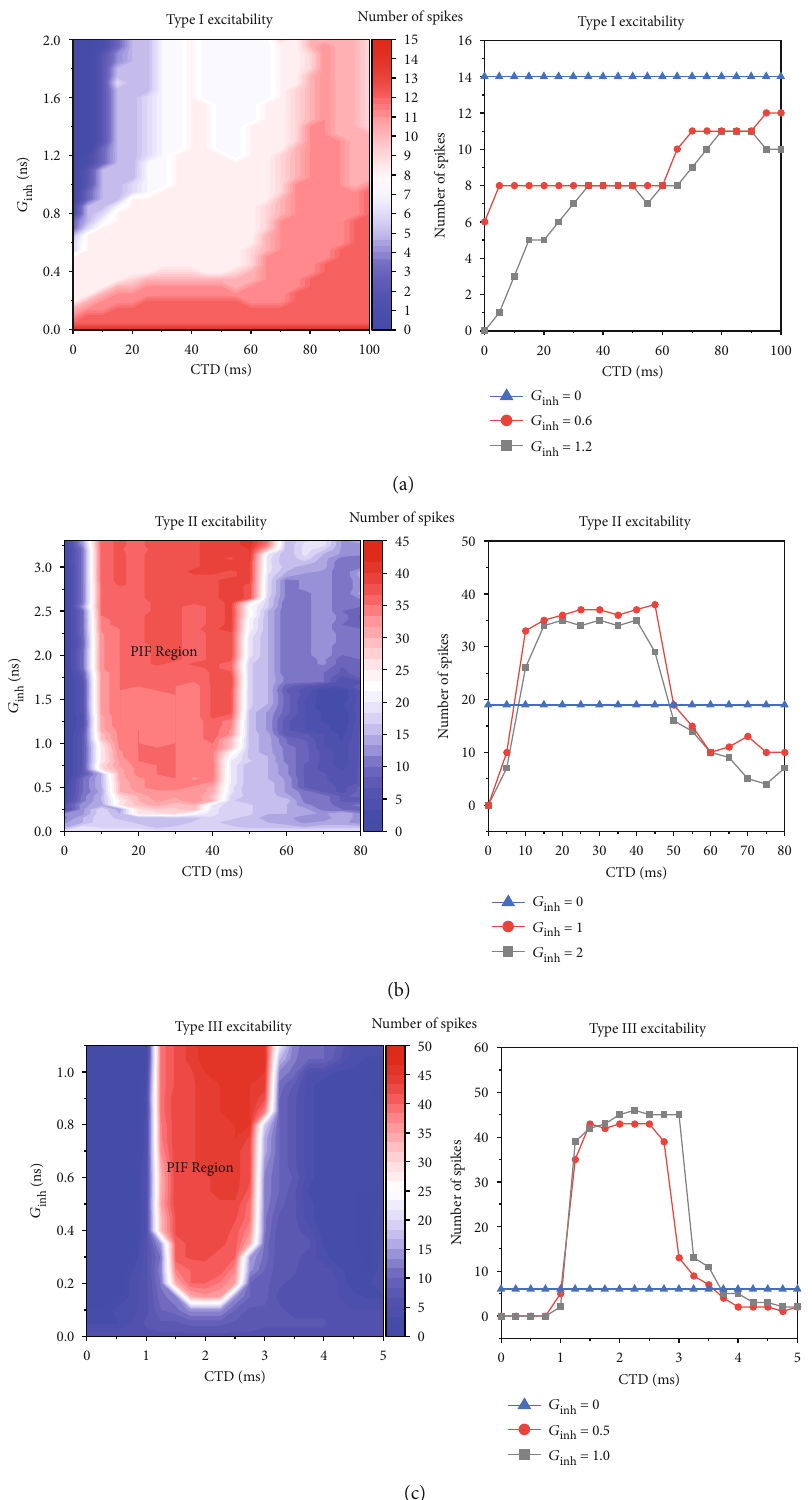
Figure 8: The dependence of the fi ring rate on both strength ( G inh ) and application timing (CTD) of the inhibitory stimulation for 3 types of excitability: (a) the fi ring rate on the plane (CTD, G inh ); (b) the changes of the fi ring rate with increasing CTD at di ff erent G inh values. Blue curve represents G inh = 0 mS/cm 2 . (a1, a2) Type I excitability. G inh = 0 : 6 (red) and 1.2mS/cm 2 (black) for G ex = 1 mS/cm 2 in (b). (b1, b2) Type II excitability. G inh = 0 : 6 (red) and 1.2mS/cm 2 (black) for G ex = 1 : 1 mS/cm 2 . (c1, c2) Type III excitability. G inh = 0 : 5 (red) and 1.0mS/cm 2 (black) for G ex = 2 : 5 mS/cm 2